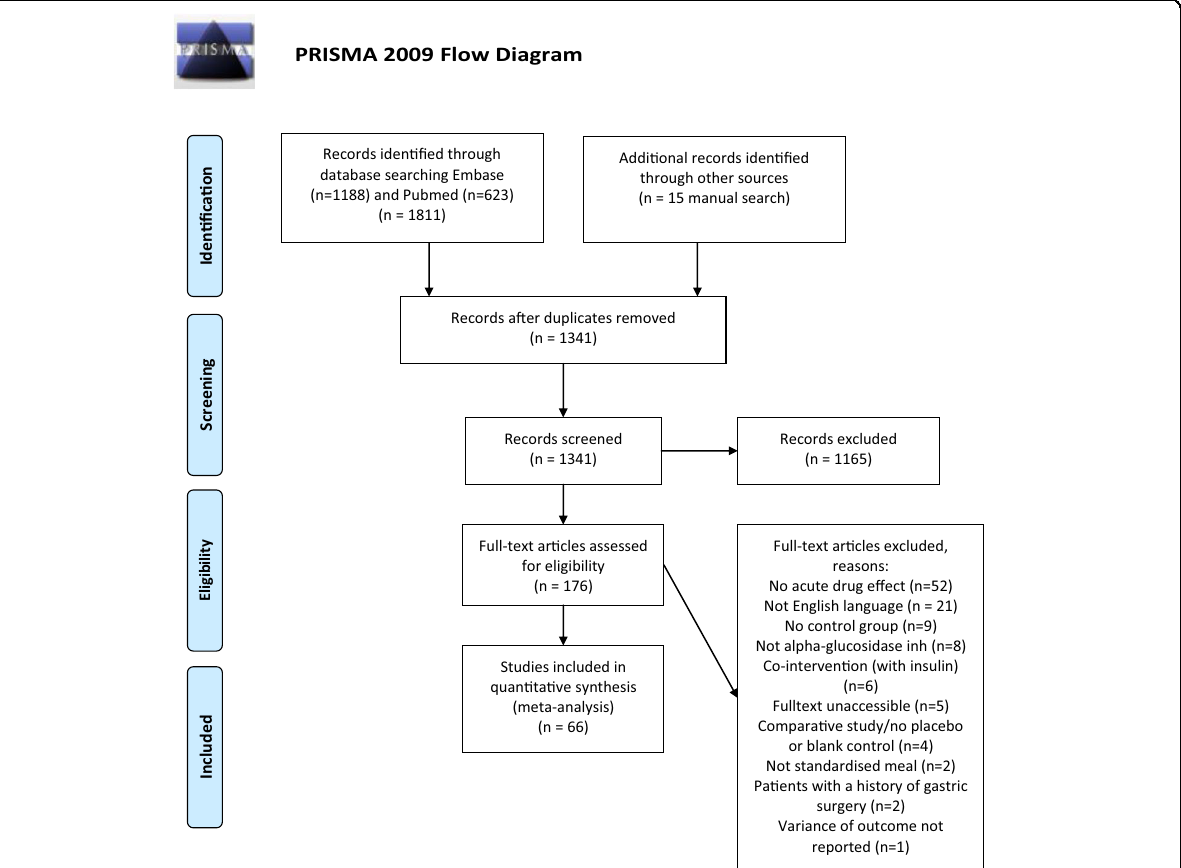
Fig. 1 PRISMA fl ow diagram of literature search: PRISMA = preferred reporting items for systematic reviews and meta-analyses. PRISMA fl